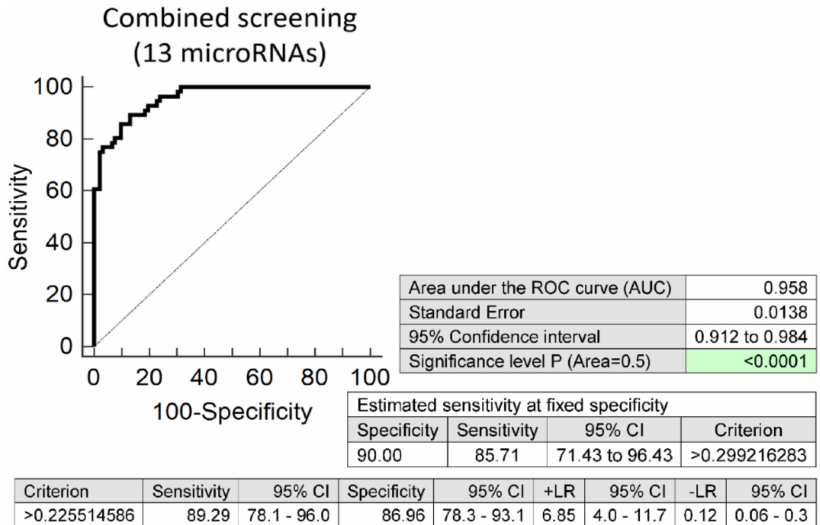
Figure 2. Altered postnatal microRNA expression profile in children descending from PTB pregnan- cies. Combined screening of 13 selected microRNAs with the best sensitivity (miR-1-3p, miR-16-5p, miR-17-5p, miR-20a-5p, miR-20b-5p, miR-26a-5p, miR-29a-3p, miR-103a-3p, miR-126-3p, miR-143-3p, miR-181a-5p, miR-195-5p, and miR-499a-5p) reveals 85.71% children with a potential cardiovascular risk at 10.0%